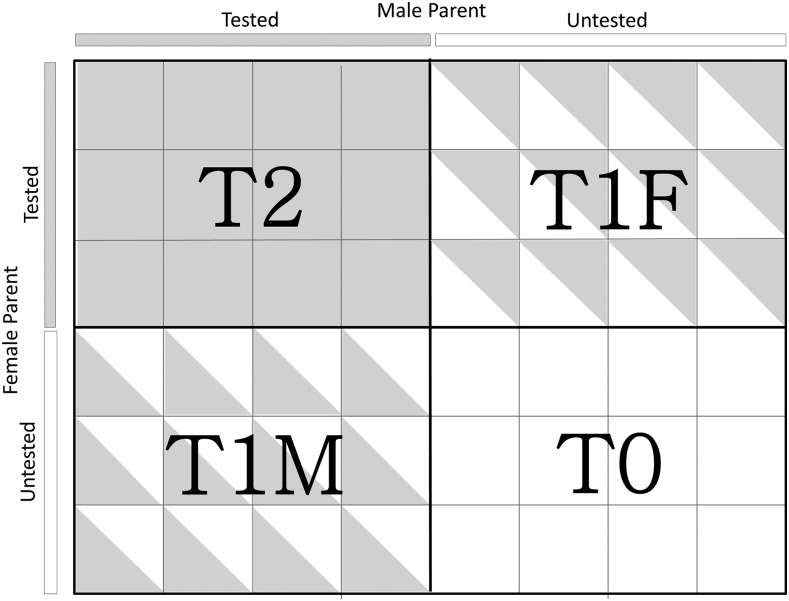
Schematic visualization of T2, T1F, T1M, and T0 cross-validation scenarios. Each small square represents one single cross. Completely filled squares (T2) indicate that both male and female parents of a single cross contained in the validation set were tested, half-filled squares indicate either the female (T1F) or male parent (T1M) of single cross contained in the validation set was tested, and unfilled squares (T0) indicate that neither parent of a single cross contained in the validation set was tested.